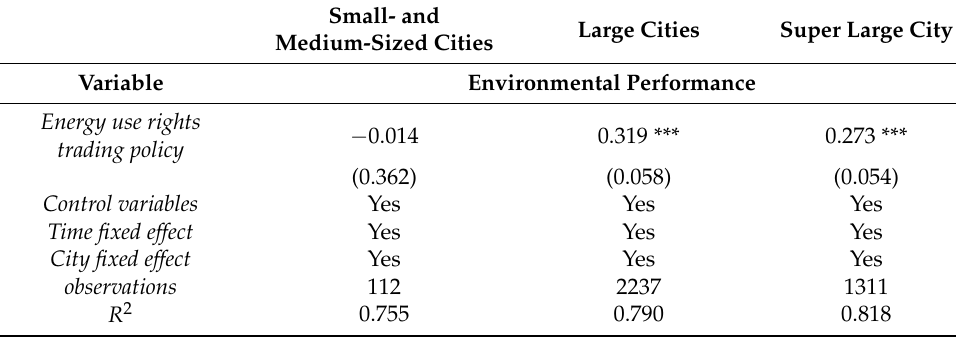
Table 3. Heterogeneity analysis of different city